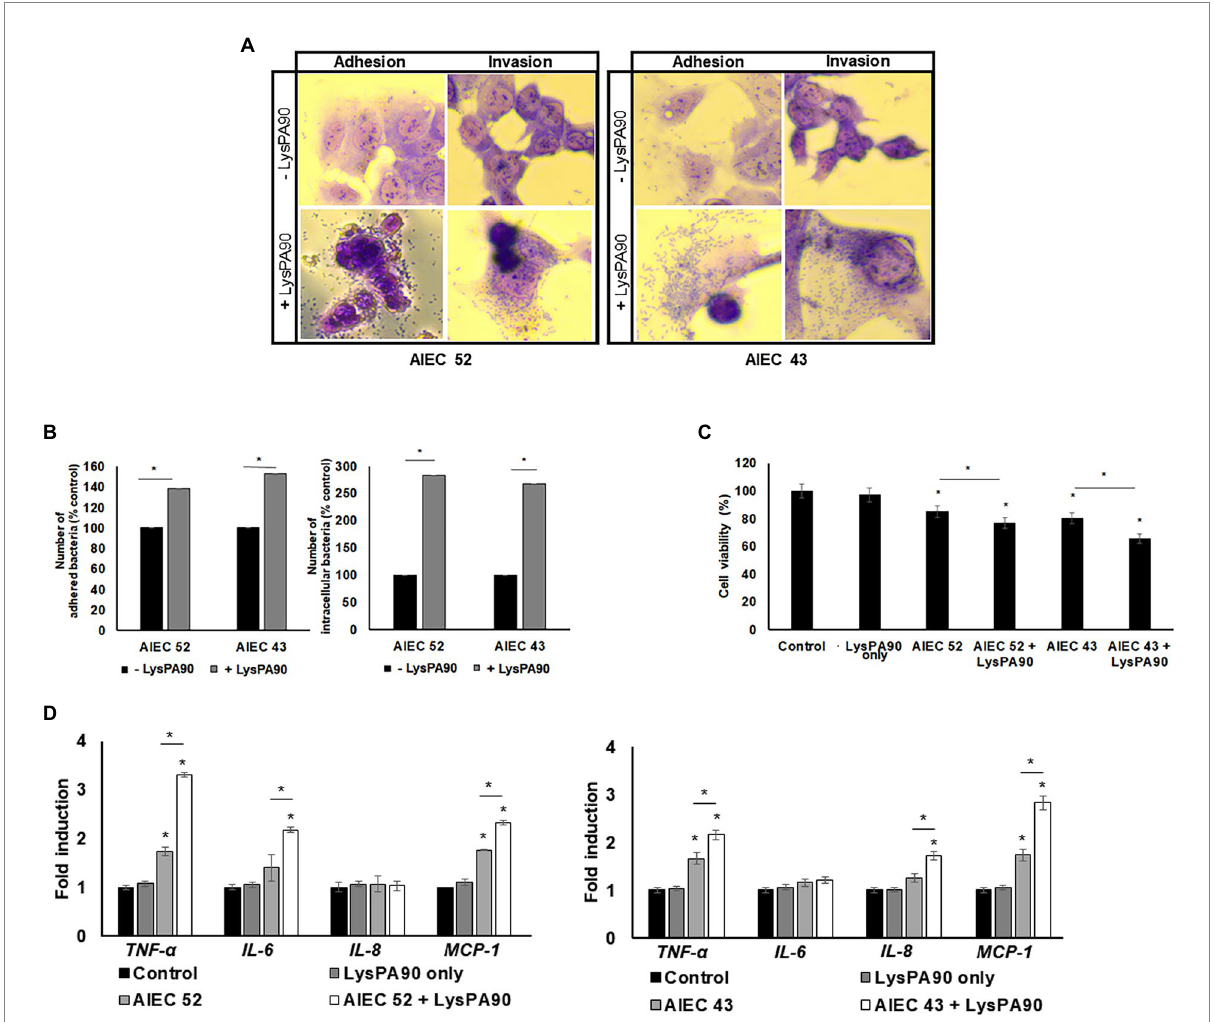
FIGURE 6 Changes in epithelial Caco-2 cells co-cultured with AIEC strains in the presence of LysPA90. (A) Microscopic observation of adhesion or invasion of AIEC strains to Caco-2 cells. Co-cultured AIEC and Caco-2 cells were treated with PBS or LysPA90 to examine any change in the adherence of the bacteria. The culture was further treated with PBS or gentamycin to remove any bacteria outside Caco-2 cells to examine any change in invasion. (B) Counting of AIEC cells which adhered to (left) or invaded Caco-2 cells (right). (C) MTT assay of Caco-2 cells co-cultured with AIEC strains in the absence or presence of LysPA90. LysPA90 only (without AIEC strains) was used as a control. (D) Realtime RT-PCR analysis of gene expression related to inflammation from Caco-2 cells in the presence of AIEC strains and LysPA90. Experiments were performed in triplicate. Data are expressed as mean ± standard